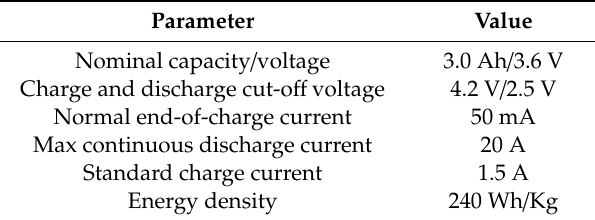
Table 1. The main specifications of LG